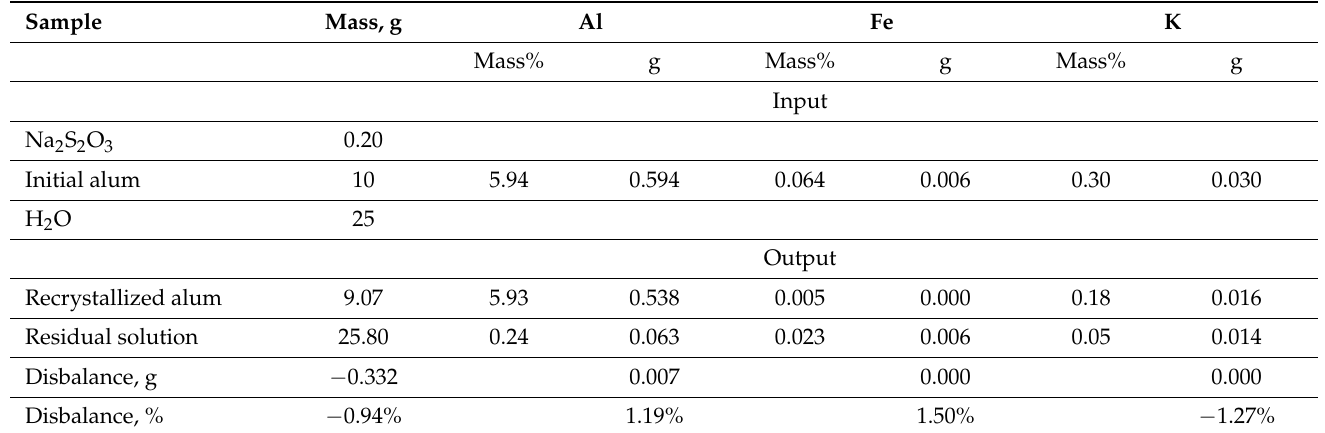
Table 2. Material balances for Al, Fe, and K at the stage of alum